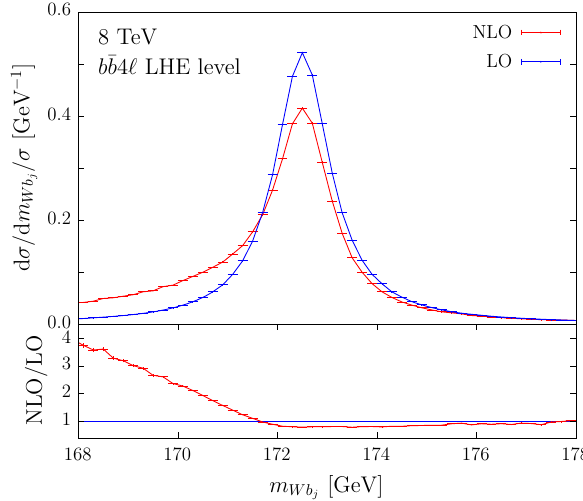
Fig. 2 d σ/ dm Wb distribution at LO (blue) and at NLO (red) obtained j with the b ¯ b 4 (cid:4) generator, normalized to 1 in the displayed range. In the bottom panel the ratio with the LO prediction is shown